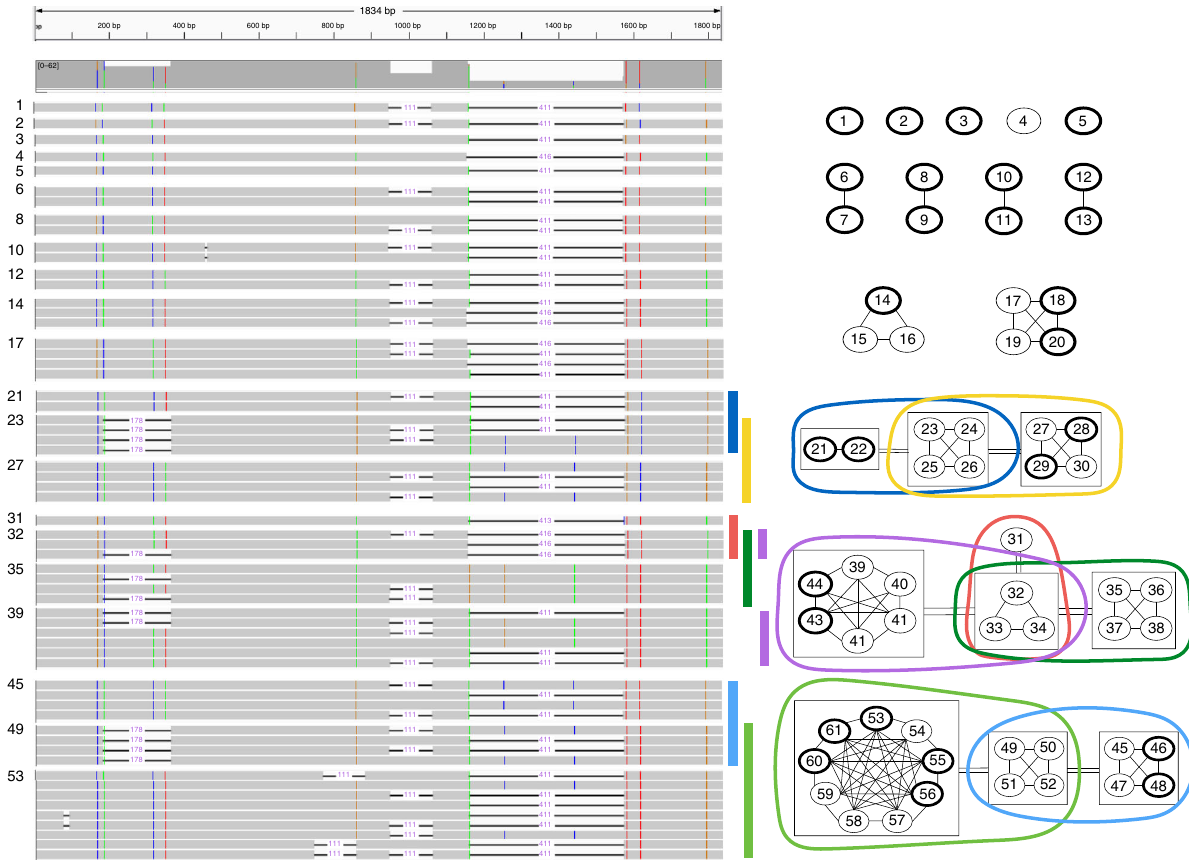
Fig. 5 Illustration of the relationship between the 61 RBMY transcripts predicted by IsoCon and shared by both samples. Transcripts are indexed from 1 to 61. The left part of the fi gure uses IGV 65,66 to visualize a multiple-alignment of the transcripts. Colored positions are positions with variability in the transcripts while grey regions depict conserved positions. Deletions are shown with a horizontal line, with a number indicating their length. The right part of the fi gure illustrates the relationship between the 61 transcripts as a graph. Vertices are transcripts (labelled with their indices). A vertex is boldfaced if it is predicted to be protein-coding. An edge between two transcripts means that they are potential isoforms from the same gene copy, i.e., they have only exon presence/absence differences. To simplify the visualization, some of the vertices are surrounded by boxes, and a double-edge between two boxes indicates that all pairs of transcripts, between the two boxes, are potential isoforms from the same gene copy. Each maximal clique (i.e. group of vertices) greater than four vertices is shown as a colored circle. The colors of the circles correspond to the rows in the multiple-alignment that are marked with a similarly- colored vertical bar. A maximal clique should be interpreted as all transcripts that potentially originate from the same gene